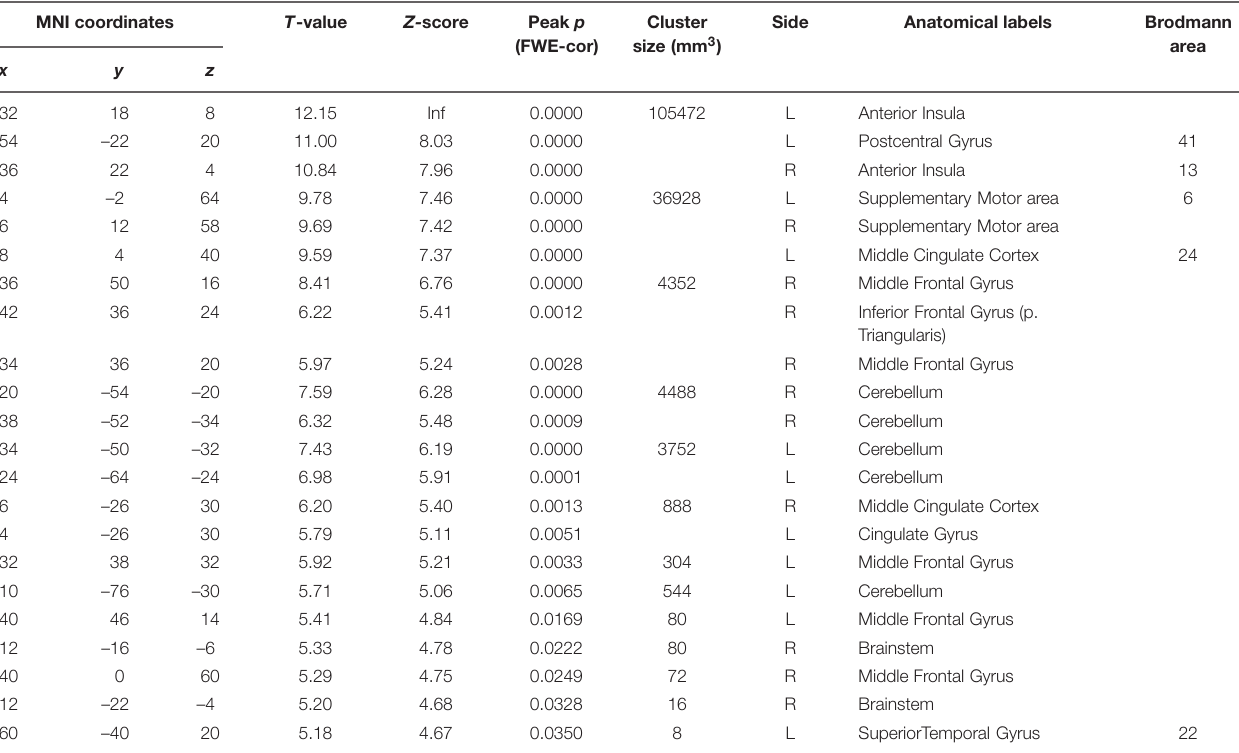
TABLE 1 | Conjunction analysis on brain regions activated by application of the three different